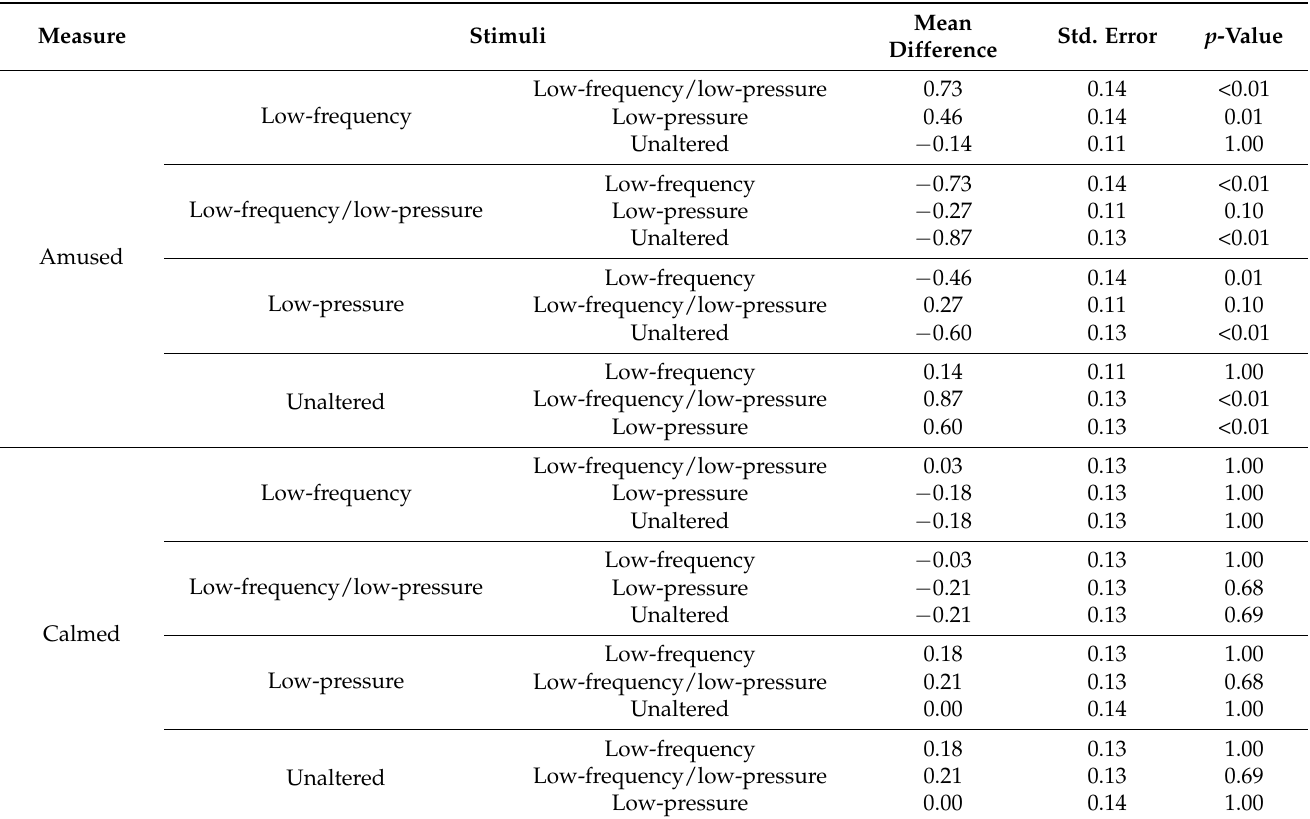
Table A1. Summary of the results of the pairwise comparisons of Experiment 1 within-participants condition (sound manipulation) for emotion